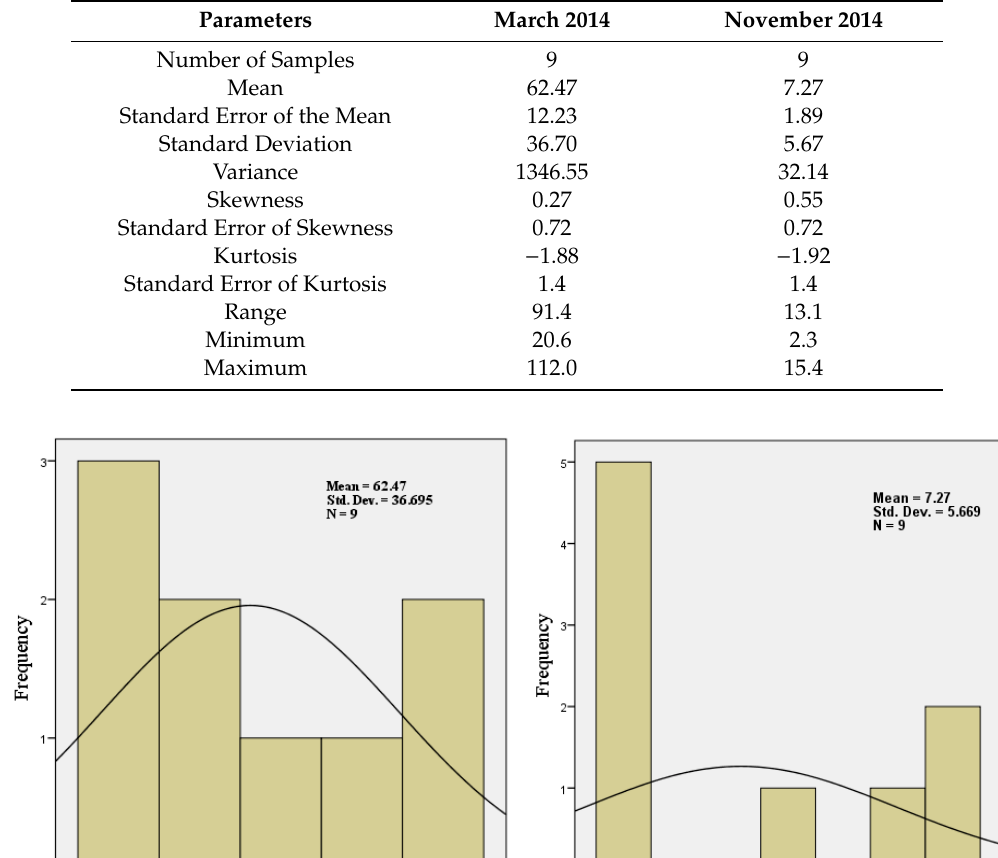
Table 3. Descriptive statistics values of turbidity in March and November 2014.